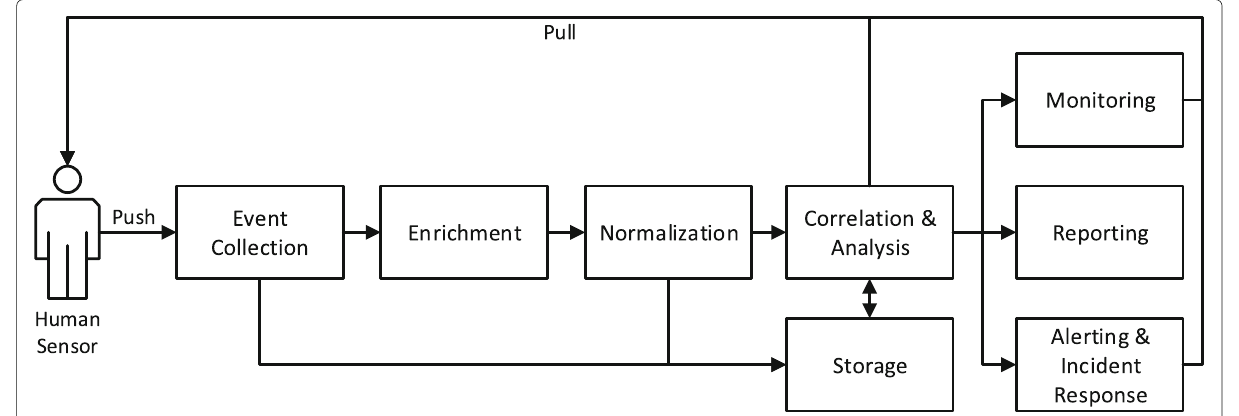
Fig. 2 Integrating human-as-a-security-sensor into the SIEM Data